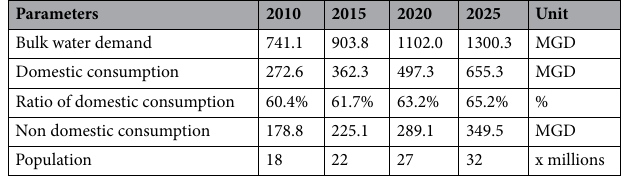
Table 3. Projections of future water demands based on KWSB study and Japan International Cooperation Agency (JICA 2008).